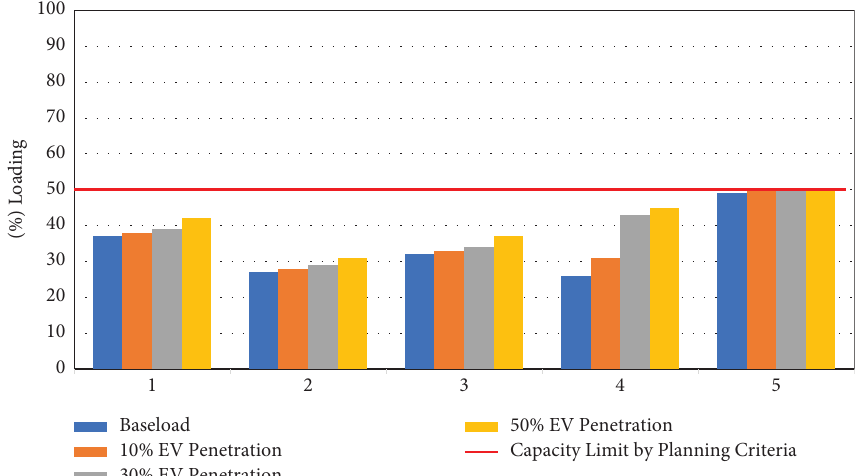
Figure 17: Percent loading of primary feeders under the three scenarios of EV penetration for smart